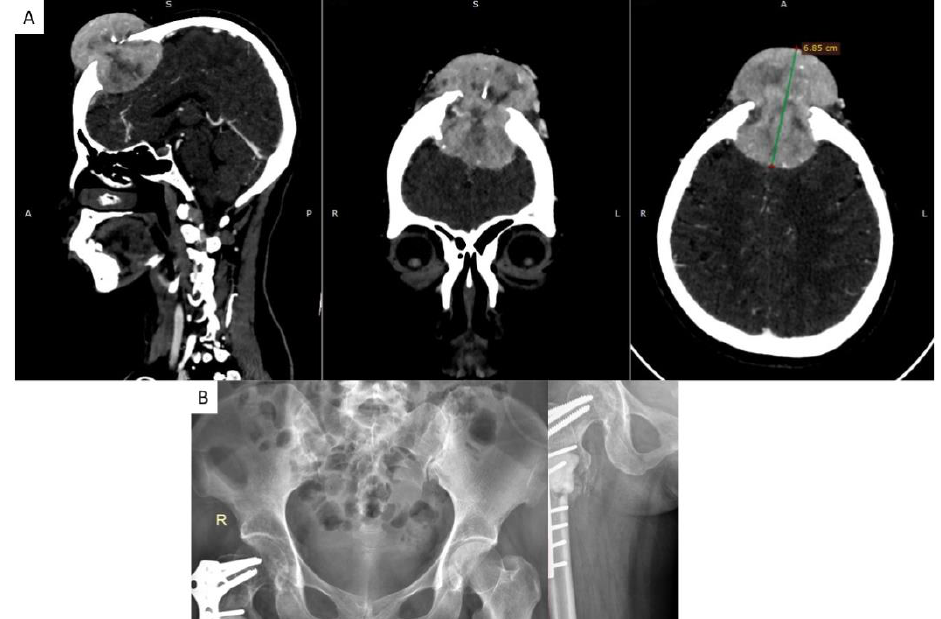
Figure 2. ( A ) Head CT-scan demonstrated a skull lesion in the frontal region with the overlying lytic bone lesion. ( B ) Pelvic X-ray showed multiple lytic lesions at the proximal right femur and